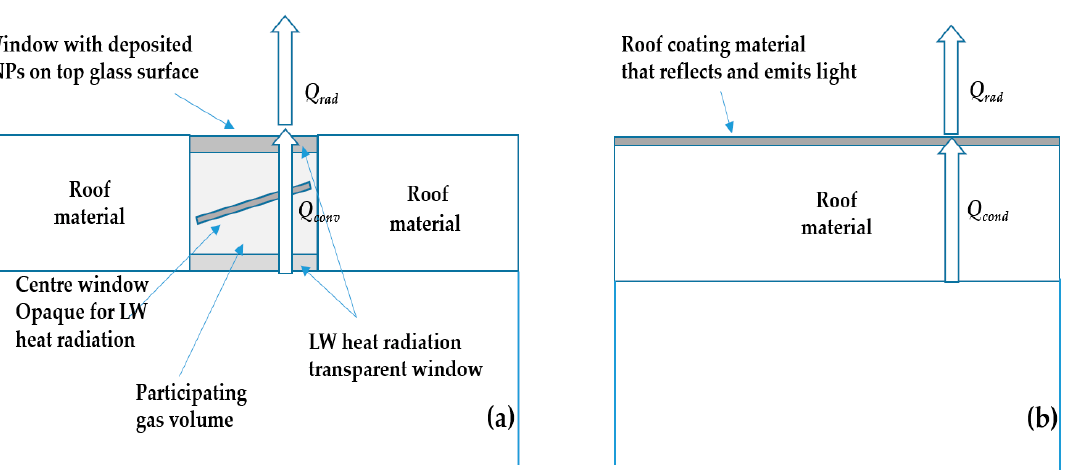
Figure 9. ( a ) A skylight design with reflective NPs on a ZnS substrate and ( b ) compared with a rooftop reflecting and emitting coating material [63].